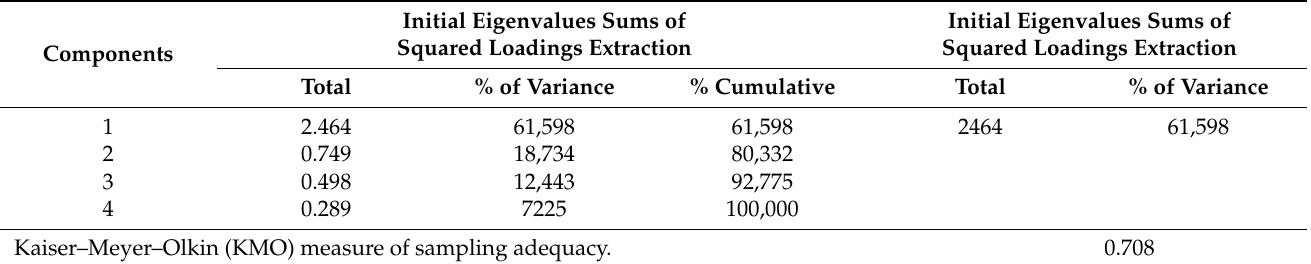
Table 5. Factorial Analysis of the “Communication among hierarchical